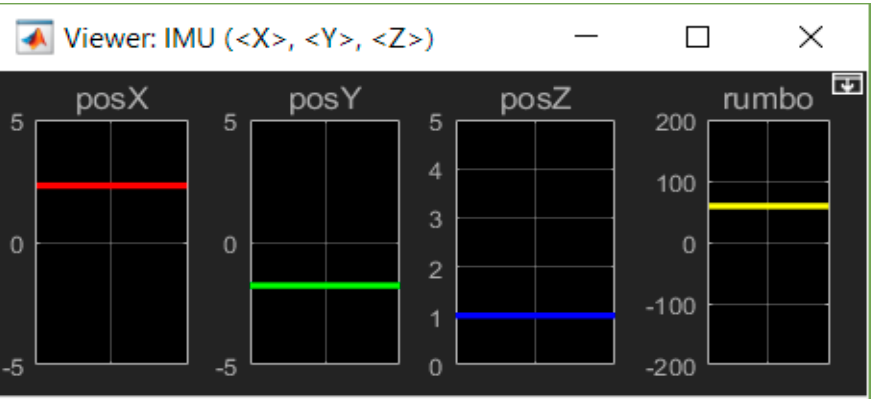
e [ x y z ψ ] (cid:124)